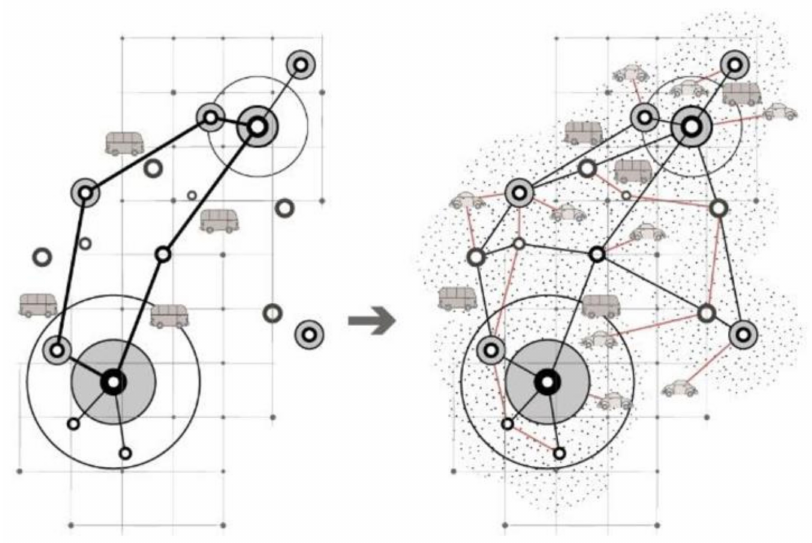
Figure 5. CAVs’ effect on the urban transport system